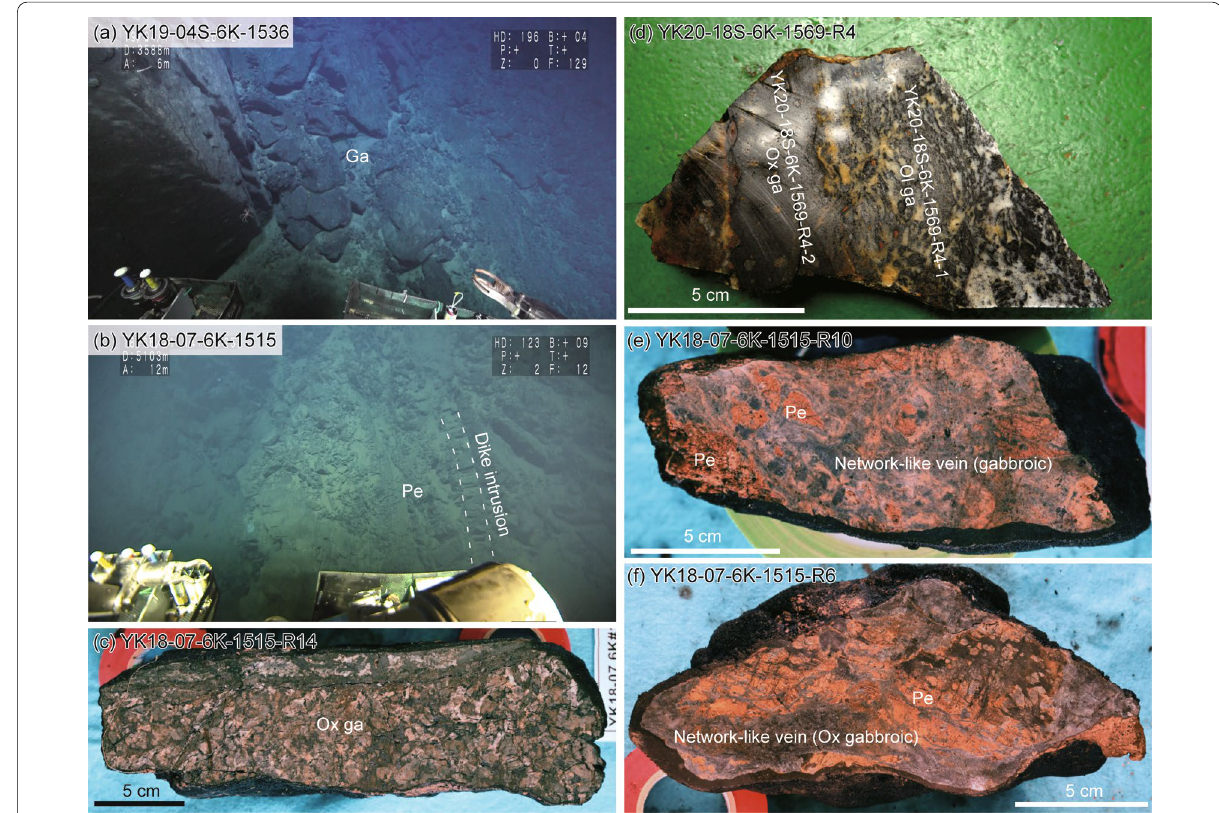
Fig. 2 Seafloor observation and rock samples from Mado Megamullion. a Representative occurrence of gabbroic rocks on the seafloor. b Representative occurrence of peridotitic rocks with platy dike intrusion on the seafloor. a , b were taken during submersible diving of 6K‑1536 and 6K‑1515, respectively. c YK18‑07‑6K‑1515‑R14 oxide gabbro. d A contact between YK20‑18S‑6K‑1569‑R4‑1 gabbro and YK20‑18S‑6K‑1569‑R4‑2 oxide gabbro. e YK18‑07‑6K‑1515‑R10 peridotite with gabbroic vein network. f YK18‑07‑6K‑1515‑R6 peridotite with oxide gabbroic vein